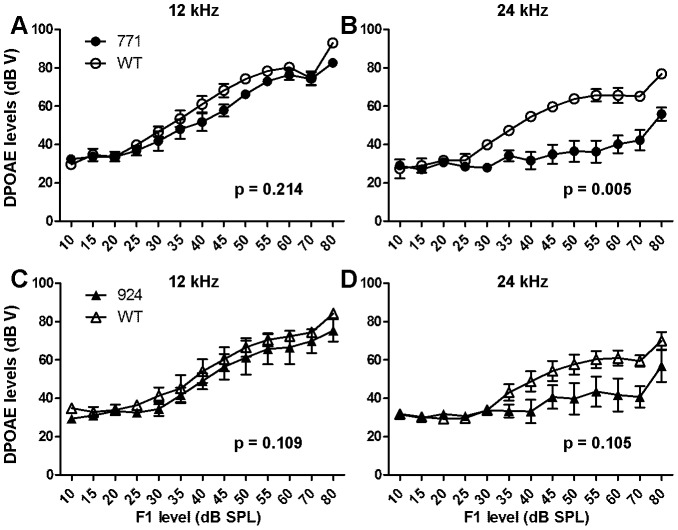

Diap3-overexpressing mice retain otoacoustic emissions at 24 weeks of age.Mean DPOAE levels at 12 kHz and 24 kHz (and mean ± SEM) are shown. Statistical significance was determined by repeated measures ANOVA. (A–B) Results for line 771 mice (filled circles, n = 6) and wild-type littermates (open circles, n = 3). (A) At 12 kHz, there was no significant difference in responses between line 771 mice and wild-type littermates, suggesting that OHC function is preserved. (B) At 24 kHz, the difference in DPOAE levels was statistically significant, indicating a loss of OHC function. (C–D) Results for line 924 (filled triangles, n = 5) and wild-type littermates (open triangles, n = 4). (C) DPOAE levels at 12 kHz were indistinguishable from those of wild-type littermates indicative of preserved OHC function. (D) At 24 kHz, although the differences were not statistically significant, there was clear inter-animal variation among the line 924 mice.